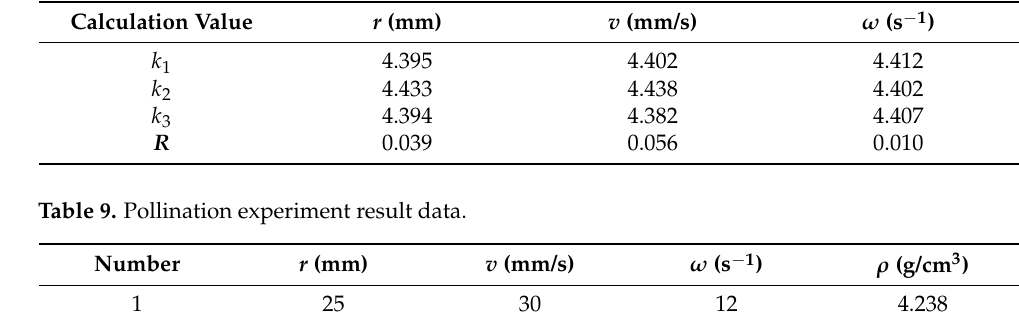
Table 8. Results of the range analysis.